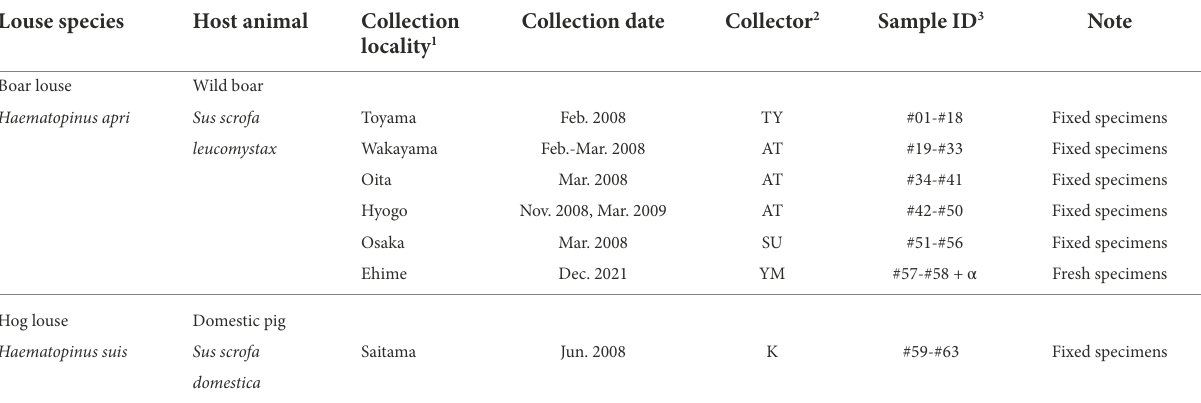
TABLE 1 Samples of the boar louse H. apri and the hog louse H. suis examined in this study. Louse